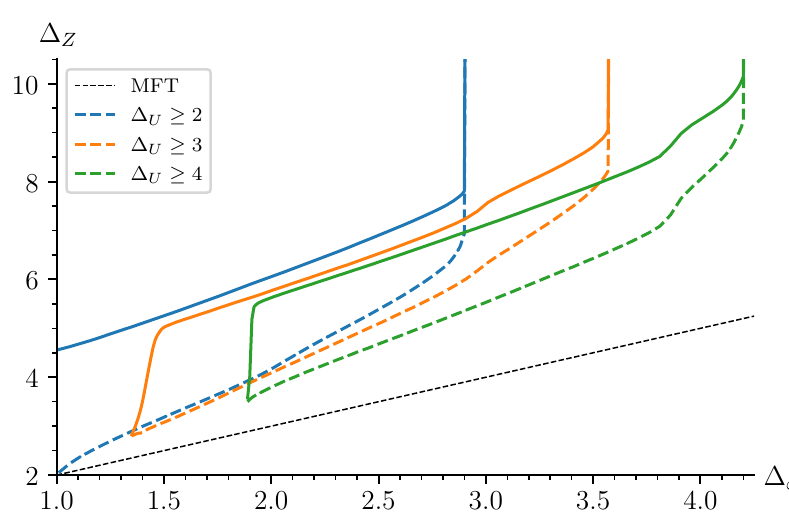
Figure 9 . Upper bounds on the dimension of the first unprotected multiplet in the ϕ × M OPE, as a function of the dimension of the Coulomb branch operator ϕ and the gaps in the U channel ∆ U ≥ { 2 , 3 , 4 } . The solid line corresponds to the most general case, when the short operator ϕM sits at the unitarity bound ∆ = ∆ ϕ + 1 and ∆ Z is the position of the first long operator. The dashed line is obtained by the further assumption that the short operator is not present. All results are obtained with Λ = 24